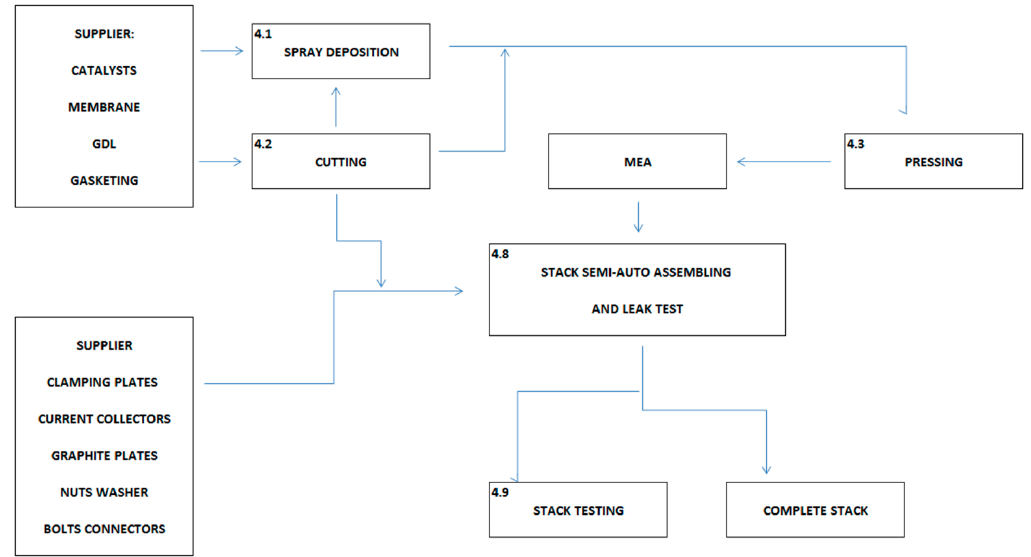
Figure 3. Block diagram for stack production. The internal processes are indexed with reference to the discussion.